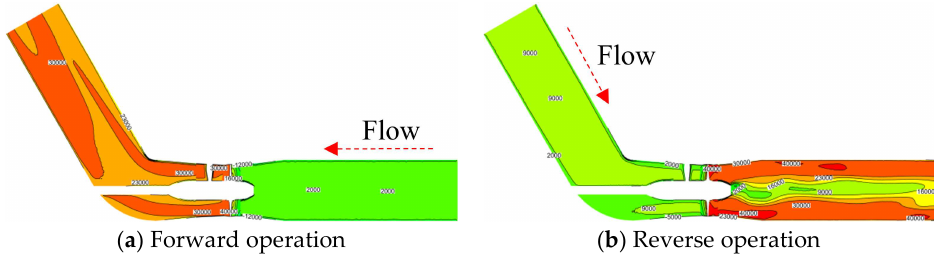
Figure 15. 1.1 Q d clouds of total pressure distribution in the middle cross section.